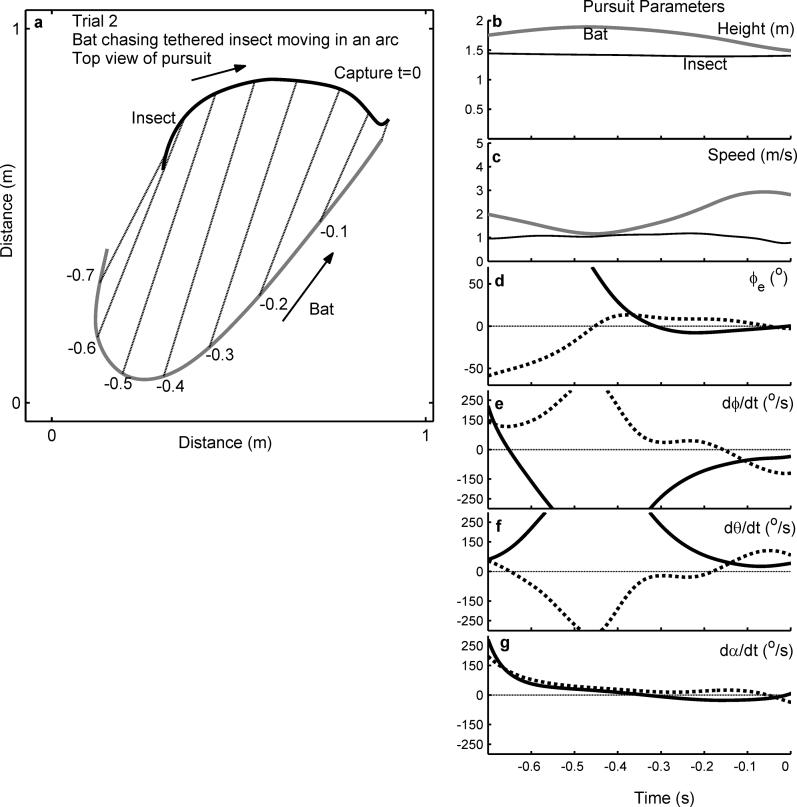
Bat Chasing a Tethered Insect(A) Bat (gray line) chased a tethered insect, moved in an arc (black line), captured it at time
t = 0. Bearing lines (black dotted) are drawn from the bat to the target every 100ms. Numbers along the flight path indicate the time in seconds to capture.
(B and C) The height (B) and speed (C) of the insect were more constant than in
Figure 2.
(D) The bat maneuvered to drive
φ
e→ 0 in the horizontal (solid line) and vertical (dotted line).
(E) The bearing (
φ) converged to a constant value (solid line, horizontal; dotted line, vertical).
(F) The direction of flight (
θ) converged to a constant value (solid line, horizontal; dotted line, vertical).
(G) The rate of change of absolute target direction converged to zero (solid line, horizontal; dotted line, vertical) before
φ
e → 0. This can also be seen in (A) from the parallel appearance of the dotted lines drawn from the bat to the insect at 100-ms intervals.